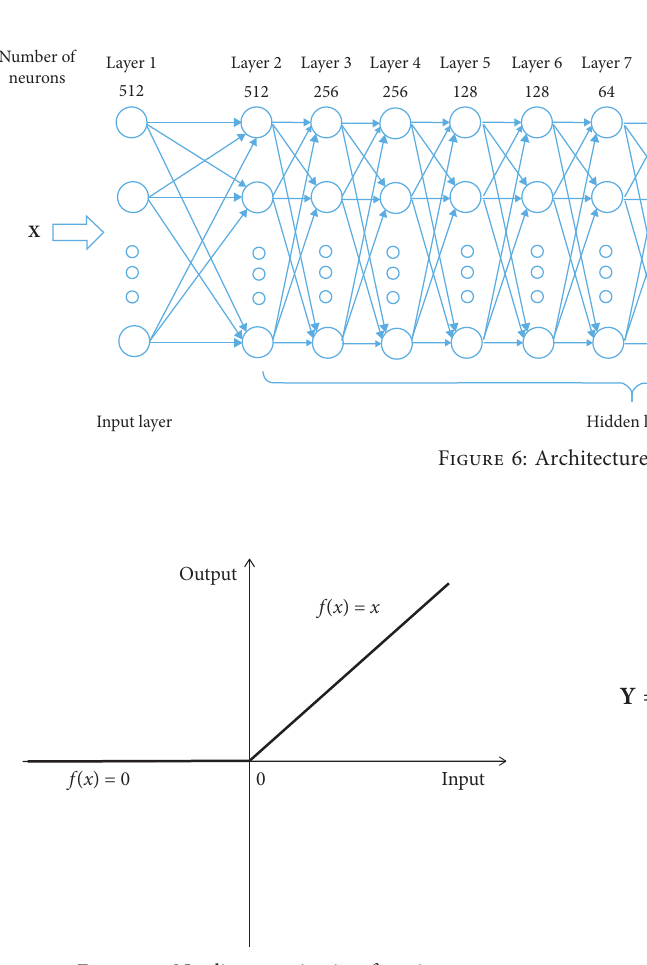
Figure 7: Nonlinear activation